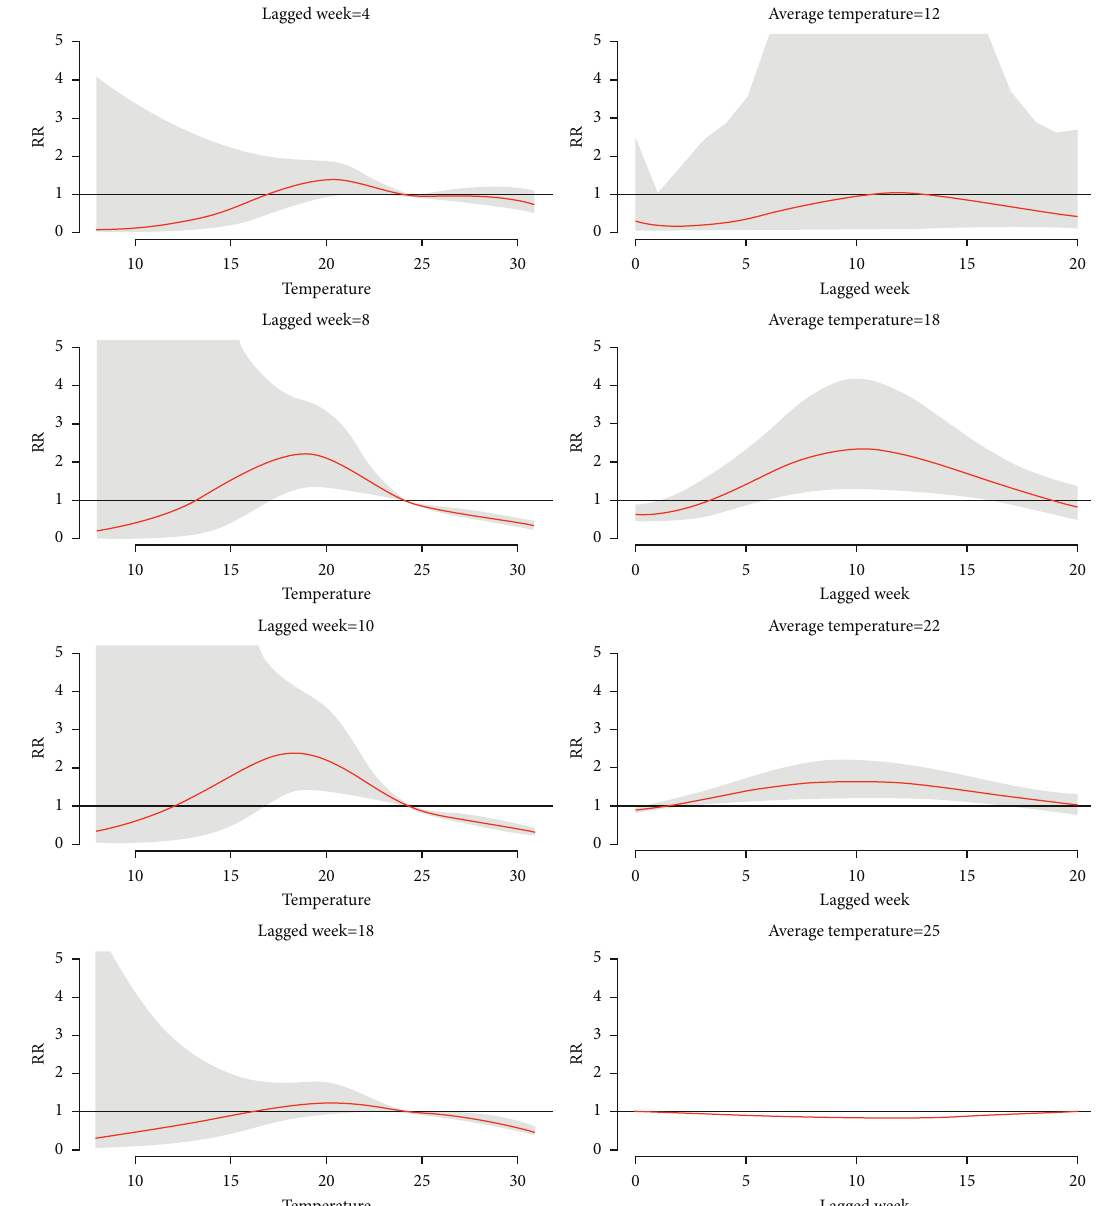
Figure 4: The estimation of relative risk of dengue fever associated with minimum temperature at selected lagged weeks (a) and lagged weeks with respect to selected minimum temperature (b). The shaded region indicates 95% confidence